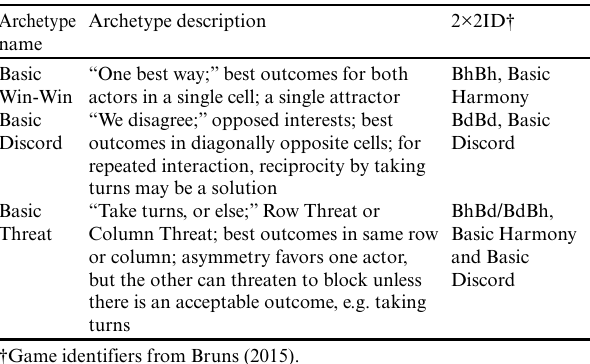
Table 1. Basic archetypes. In these archetypes, there is one preferred outcome (“like”) for each